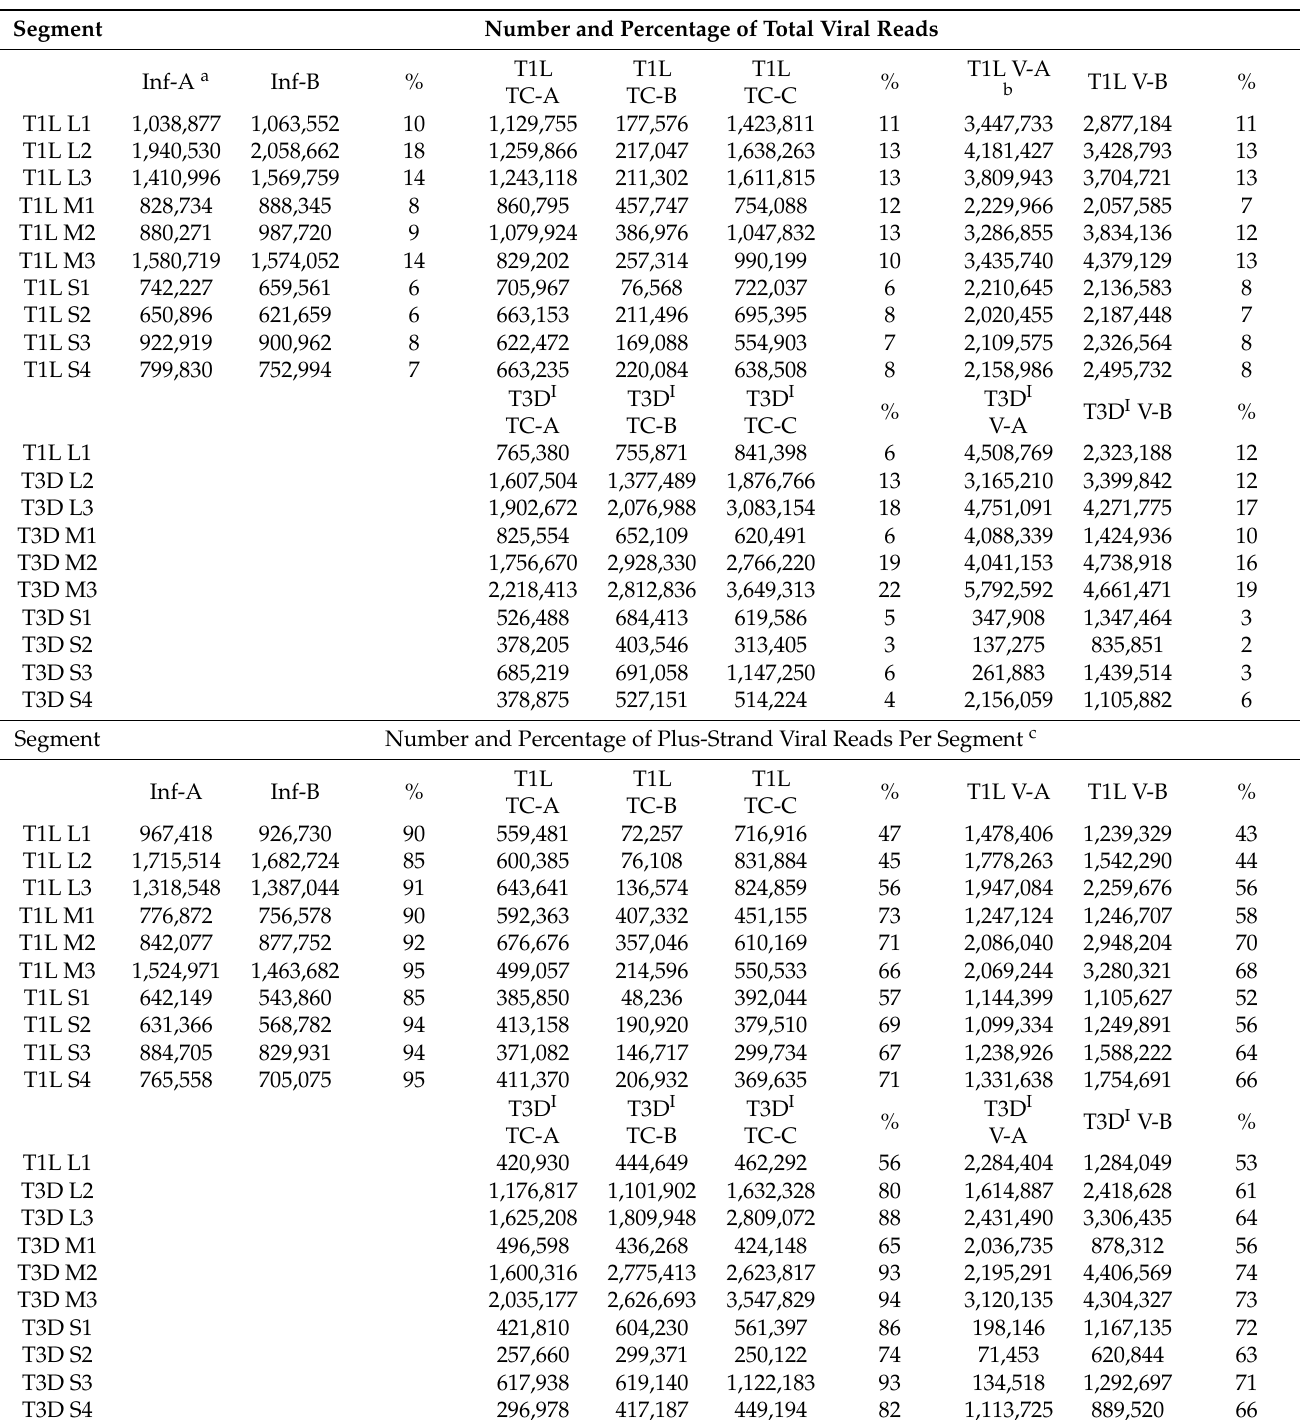
Table 1. Viral reads from rsT1L-infected L cells and rsT1L or rsT3D I T1L1 TC or